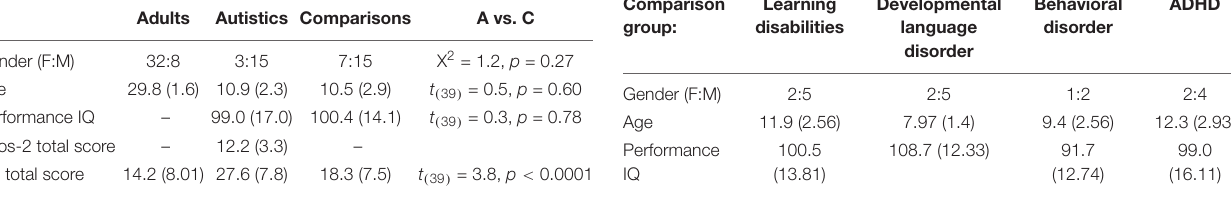
TABLE 2 | Mean (standard deviations) in each subgroup of the comparison group of non-autistic participants. Comparison